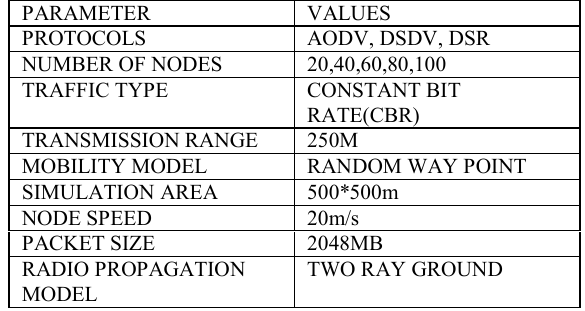
Scenario3:-The nodes are moving with a constant speed of 20m/s. The simulation time is taken to be 600ms. The number of nodes are varying from 20, 40, 60, 80 and 100 with constant packet sie of 2048Mb .